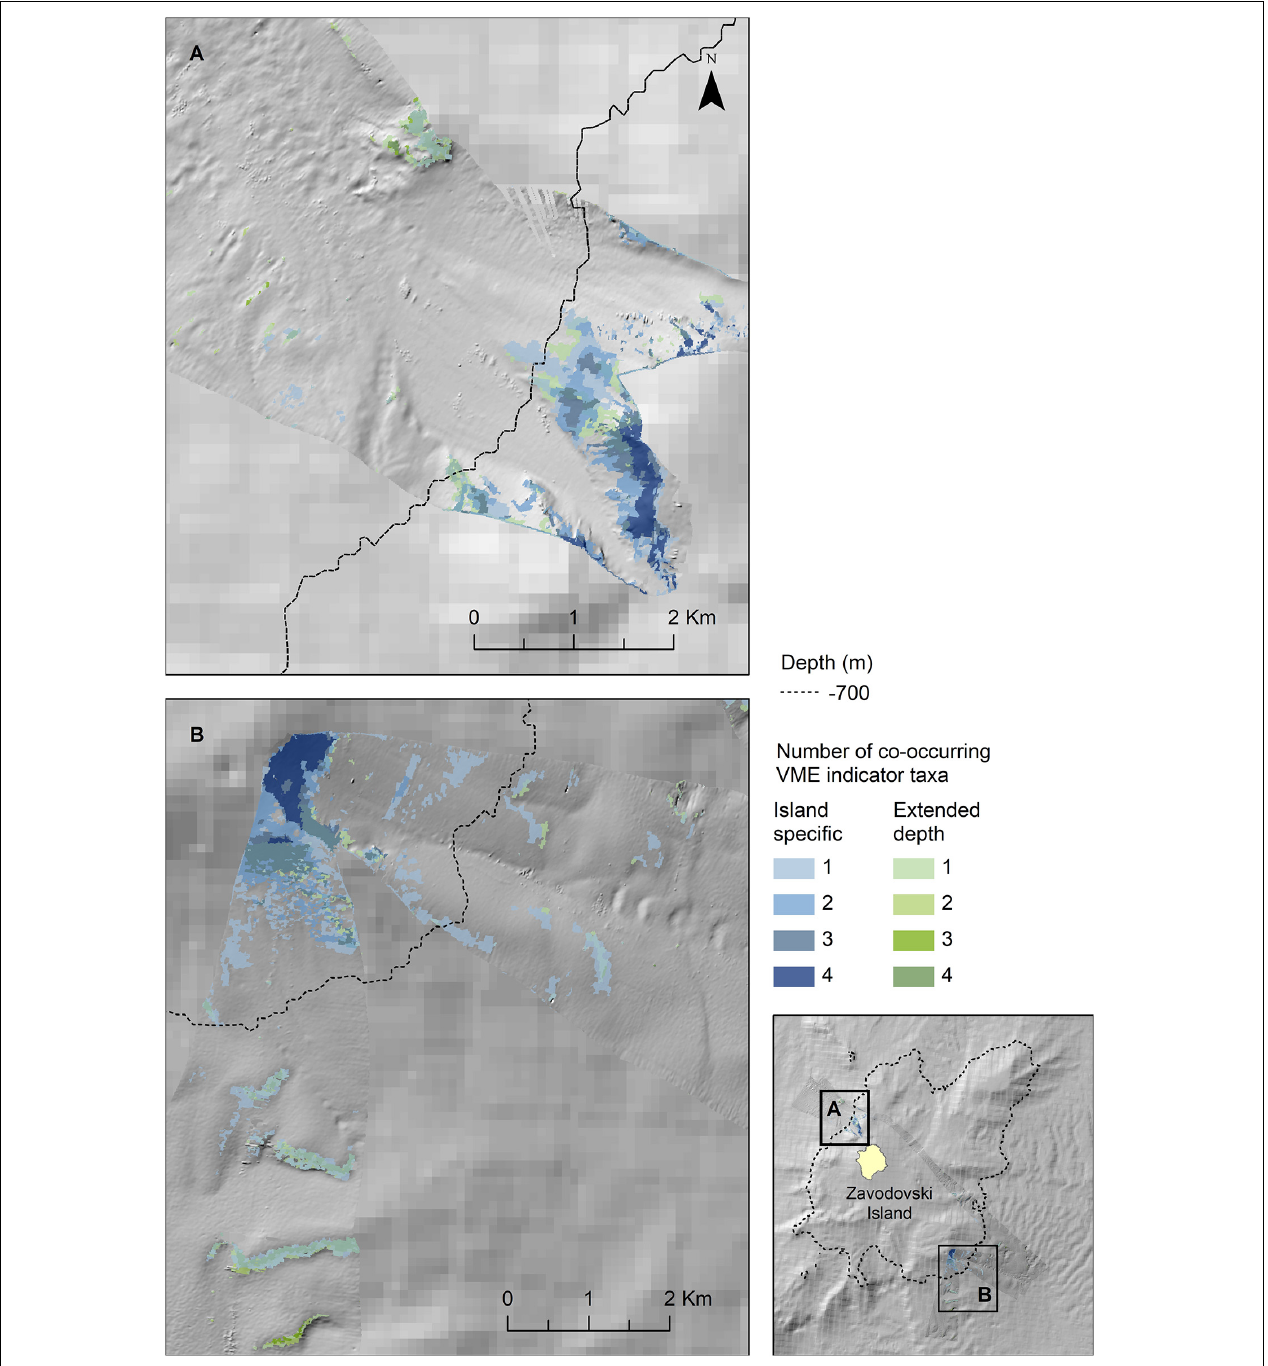
FIGURE 7 | Extrapolated extent of potentially suitable habitat for VME indicator taxa in the two survey locations to the northwest (A) and southeast (B) of Zavodovski Island. Shown values refer to the number of VME indicator taxa (bottlebrush corals, branching corals, whip corals and sponges) for which suitable habitat is likely to co-occur. Blue colours indicate the extent within observed depth limit for this location, green colours indicate topographically suitable habitat present beyond the observed depth. High resolution bathymetry from DY99 is shown overlain on the South Sandwich Islands bathymetry compilation by Leat et al.